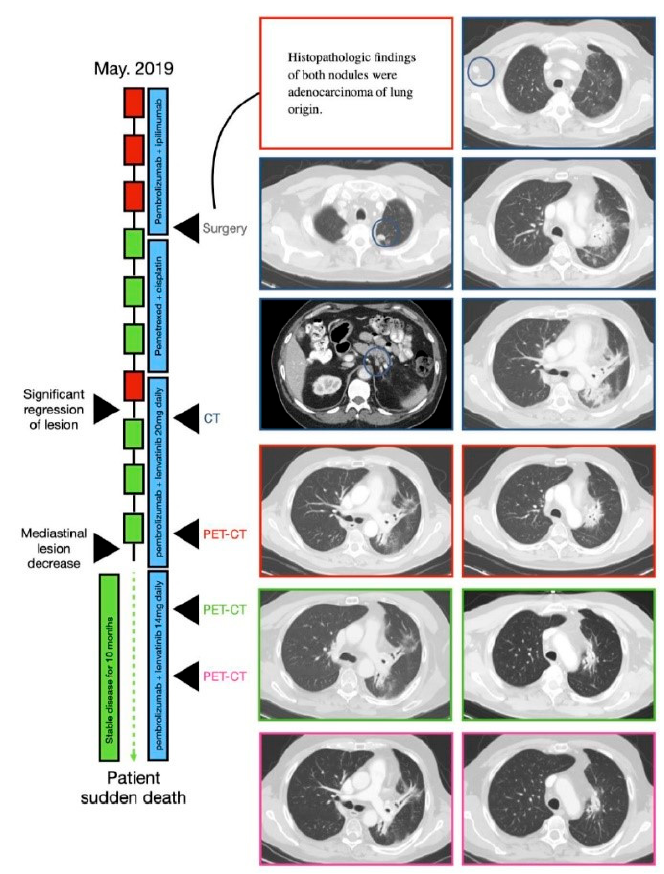
Figure 5. A schematic illustration of patient 5 ′ s timeline, between August 2016 (diagnosis of the disease) and September 2020 (patient’s death), including the course of treatment and radiological follow ‐ up. Each rectangle represents 1 month, and the response to treatment during each month is color ‐ coded in green, red, or yellow, as described in the upper legend. Treatment administered in each timepoint is indicated by the blue rectangles. Radiological findings and additional landmarks are presented at relevant points throughout the timeline.